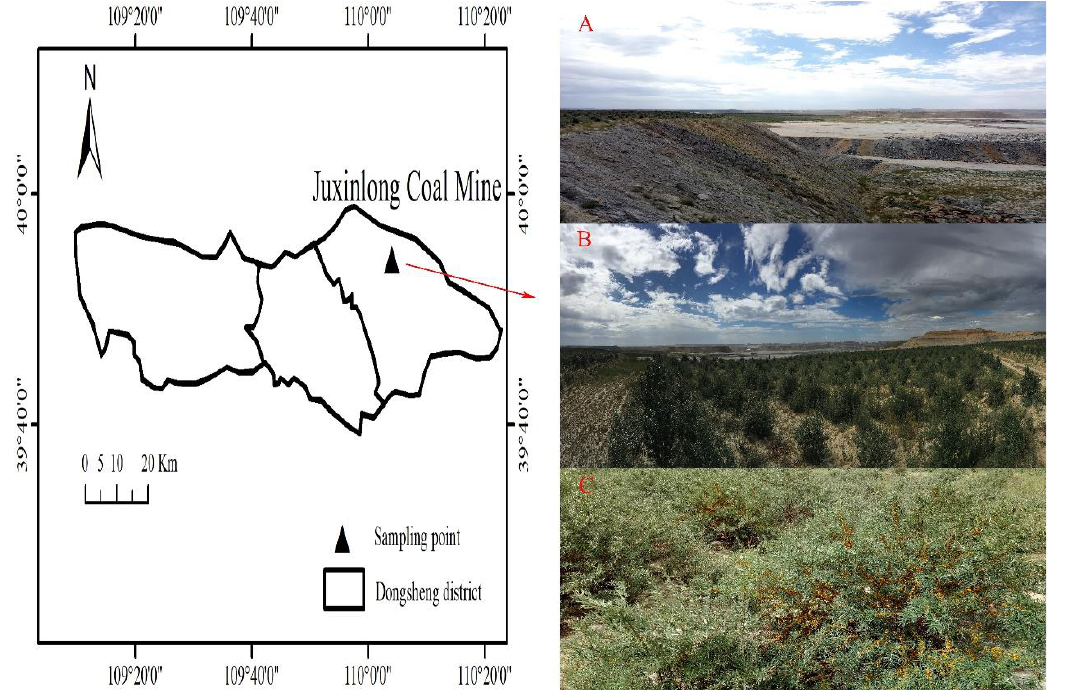
Figure 1. Sample plot map. Note: In Figure 1, ( A ) is the overview map of the mine site before restoration measures, ( B ) indicates the overview map of the mine site after the implementation of vegetation restoration measures, and ( C ) is the overview map of the sea buckthorn sample plot in mining area. Table 1. Basic information of sample land.